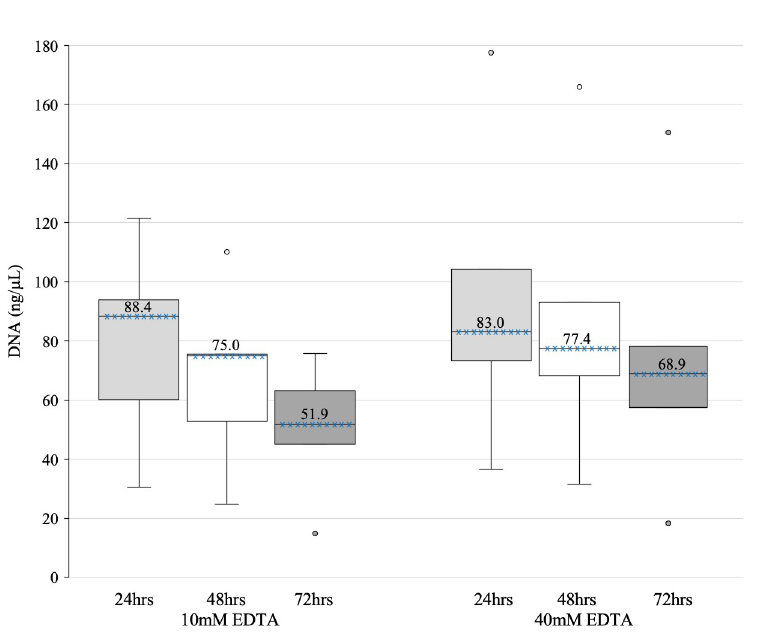
Fig 5. DNA concentration of samples processed at different times after sample collection. The top of the box represents the upper quartile (p75), the bottom the lower quartile (p25), and the line the median (p50), the median is displayed above the line. The upper and lower whiskers extend to 1.5 times the interquartile range, while the dots mark the largest and smallest values of the distribution.